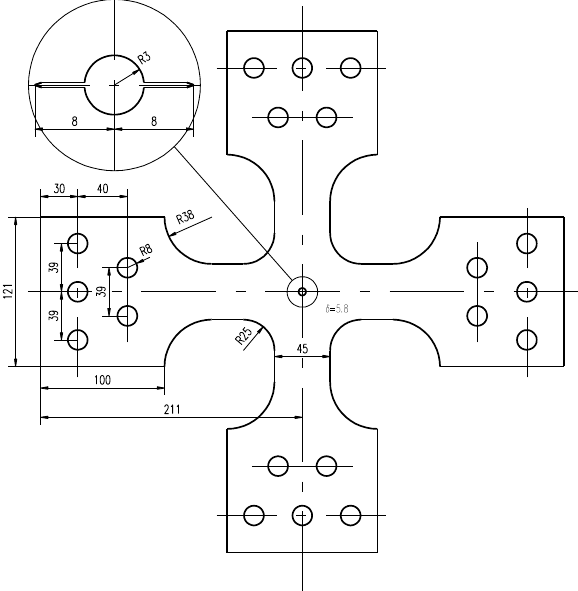
Figure 1. Dimensions of cross-shaped specimen.